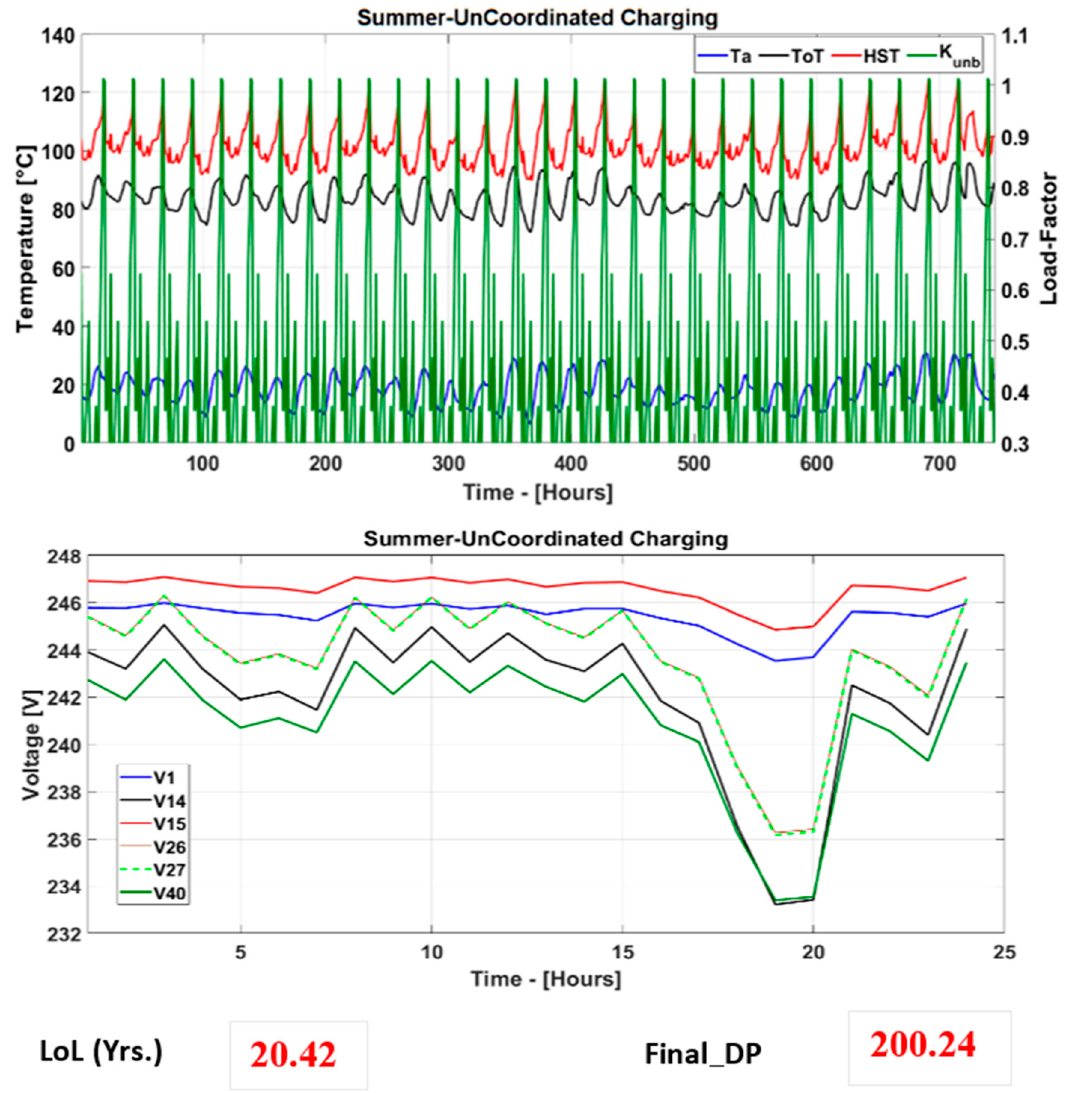
Figure 6. Output under uncoordinated charging across selected households, during summer, with BESS.